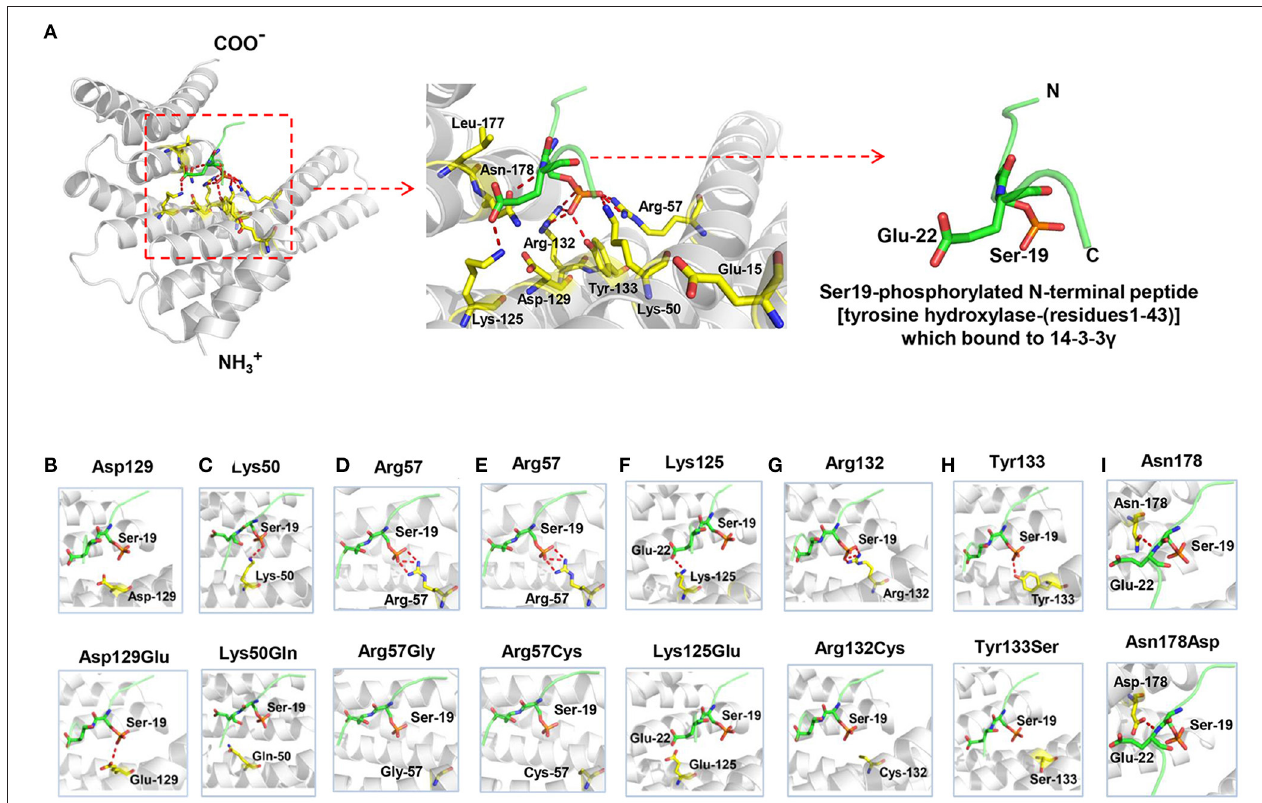
FIGURE 2 | Crystal structure of 14-3-3 γ (PDB: 4J6S) and hydrogen bond changes of the mutants. (A) Left: monomeric 14-3-3 γ is shown as gray ribbons, and the phosphopeptide ligand is shown as a green stick. Middle: close-up view of the binding groove and the side chains of the residues where mutations occurred. Right: Ser19-phosphorylated N-terminal peptide [tyrosine hydroxylase-(residues1-43)], which bound to 14-3-3 γ . (B) Substitution of aspartate with glutamate at residue 129 (Asp129Glu) led to a new hydrogen bond with phosphopeptide ligand. (C) Substitution of lysine with glutamate at residue 50 (Lys50Gln) destroyed the original hydrogen bond with phosphopeptide ligand. (D) Substitution of arginine with glycine at residue 57 (Arg57Gly) destroyed the original hydrogen bond with phosphopeptide ligand. (E) Substitution of arginine with cysteine at residue 57 (Arg57Cys) destroyed the original hydrogen bond with phosphopeptide ligand. (F) Substitution of lysine with glutamate at residue 125 (Lys125Glu) destroyed the original hydrogen bond with phosphopeptide ligand. (G) Substitution of arginine with cysteine at residue 132 (Arg132Cys) destroyed the three original hydrogen bonds with phosphopeptide ligand. (H) Substitution of tyrosine with serine at residue 133 (Tyr133Ser) destroyed the original hydrogen bond with phosphopeptide ligand. (I) Substitution of asparagine with aspartate at residue 178 (Asn178Asp) formed a similar hydrogen bond with phosphopeptide ligand.